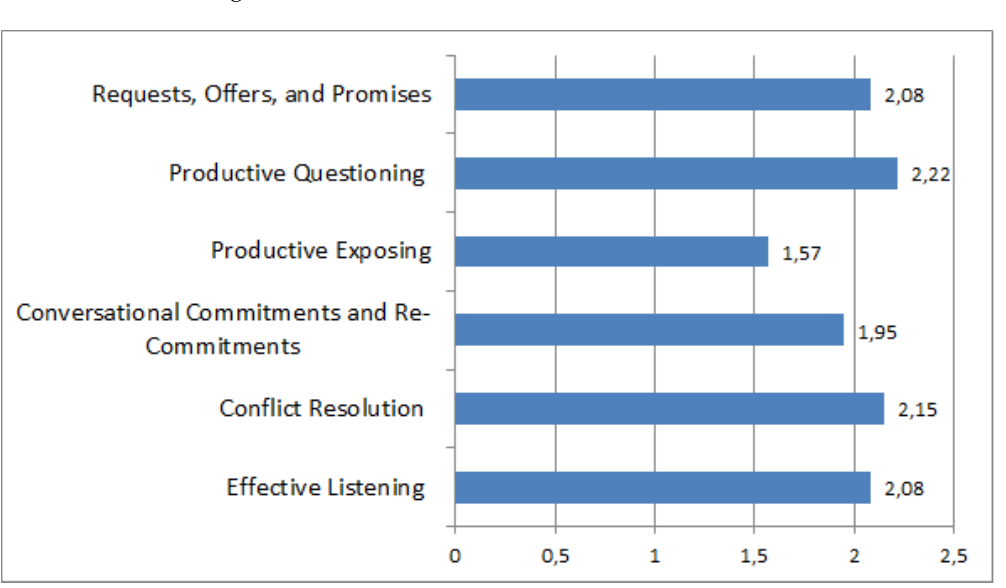
Figure 7. Conversational competency gaps.